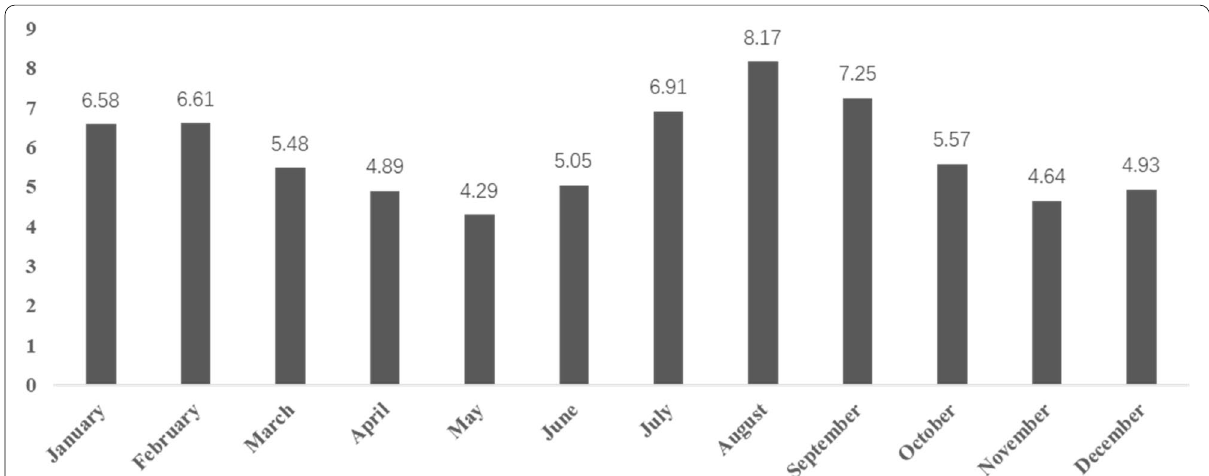
Fig. 9 Monthly basic electricity consumption statistics of the community (10 4